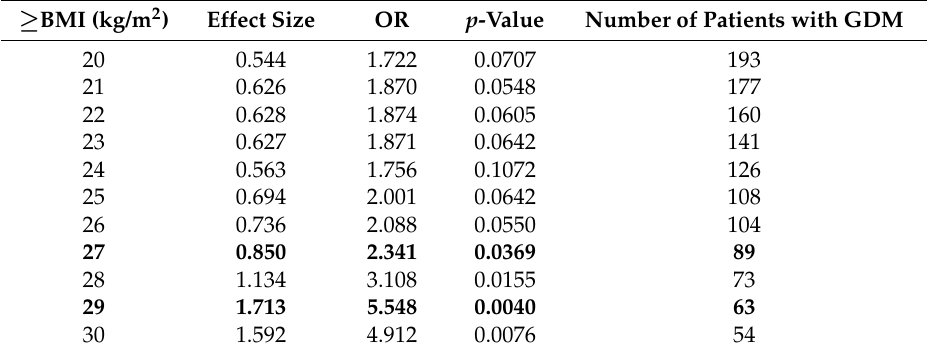
Table 2. The interaction between pre-pregnancy BMI and carrying the MTNR1B rs10830963/ G allele on the odds of AIT initiation in patients with GDM (real-life treatment data, logistic regression